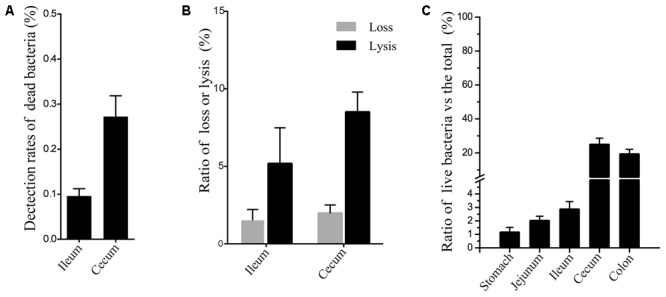
Efficacy of PMA treatment and the ratio of live bacteria in gut samples. (A) PMA-treatment efficacy in heat-sterilized pelleted cells from the ileum and cecum. The length of the bar corresponds to the ratio of residual dead bacteria. (B) Ratio of loss and lysis of live bacteria during PMA treatment. “Loss” represents the ratio of lost live bacteria along with supernatants during elution. “Lysis” represents the ratio of lysed live bacteria in the whole process. (C) Ratio of live bacteria in different sites sampled. The length of the bar corresponds to the ratio of live bacteria.